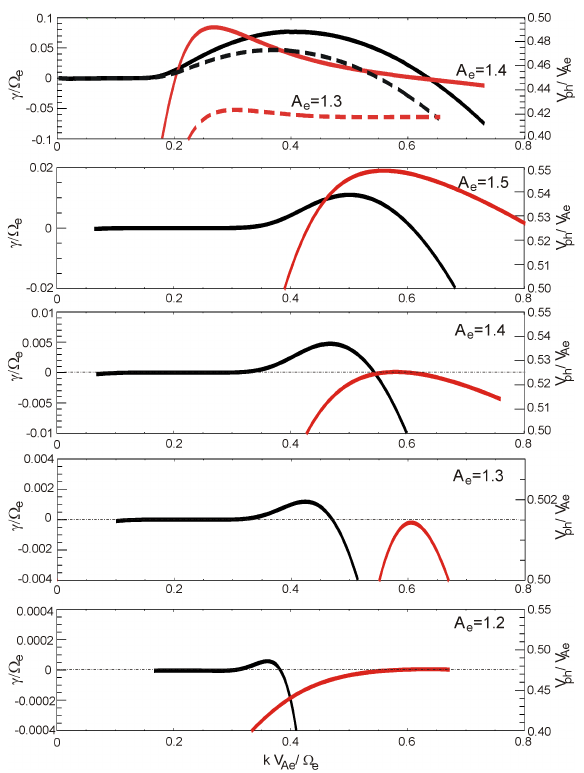
Fig. 14. Phase speed and the growth rate of whistlers generated by a temperature anisotropy